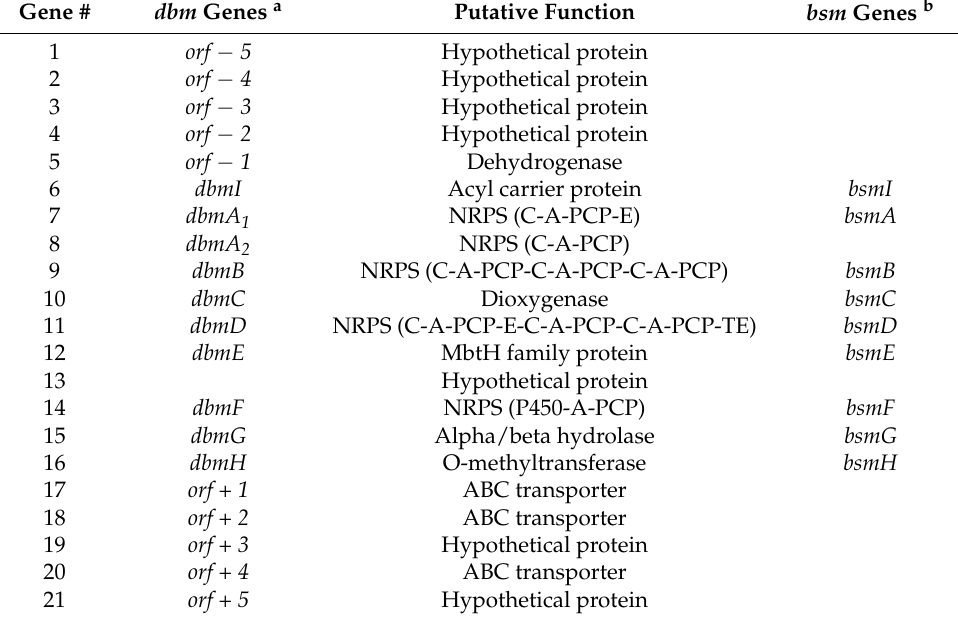
Table 1. Genes encoded within the chromosomal fragment cloned in BAC I7 and annotation of the bsm and dbm